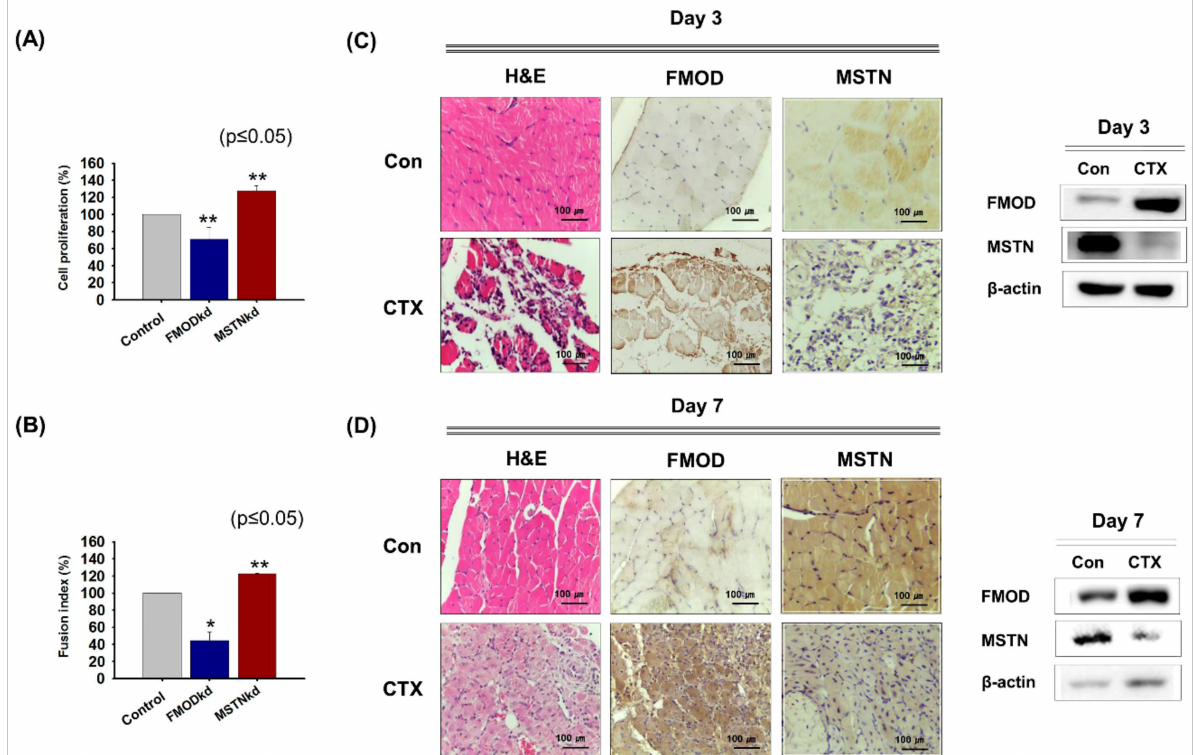
Figure 1. FMOD and MSTN gene expressions during myoblast proliferation, differentiation, and muscle regeneration. ( A ) FMOD and MSTN knockdown C2C12 cells were incubated with growth media for 2 days and cell proliferation was assessed using an MTT assay. ( B ) FMOD and MSTN knockdown cells were incubated in differentiation media for 4 days. Cell nuclei were stained with Giemsa solution and then fusion indices were calculated by expressing the number of nuclei integrated into myotube as a percentage of the total number of nuclei. ( C , D ) CTX was injected once into gas muscles and mice were sacrificed 3 or 7 days later. Expressions of FMOD and MSTN in control and CT- injected muscles were assessed immunohistochemically and by Western blot. FMODwt and MSTNwt indicate cells transfected with scrambled vector. Means ± SD (n > 3). * p ≤ 0.05, *** p ≤